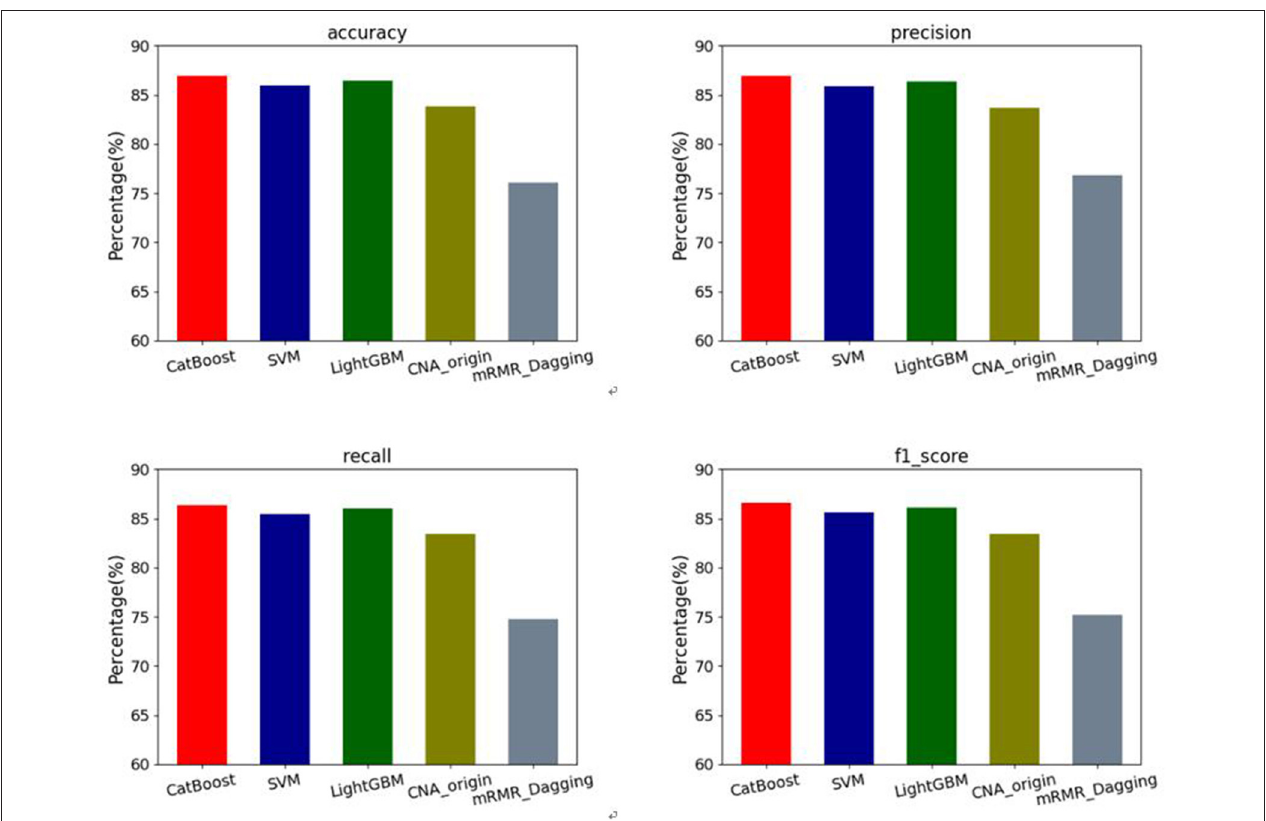
FIGURE 3 | Performance comparison of 4 evaluation metrics: accuracy, precision, recall and F1-score among our methods and the other two algorithms (CNA_origin and